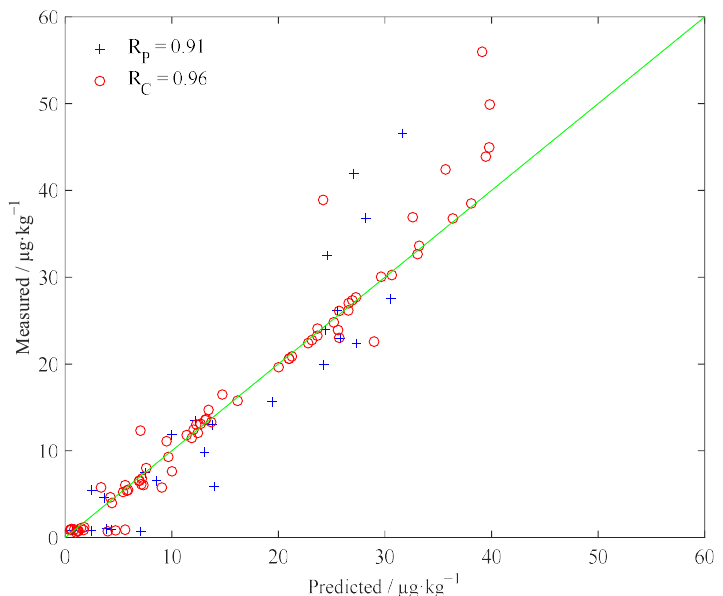
Figure 4. Scatter plot between the predicted value of the AFB 1 in peanuts by the optimal SSA-SVR model and the reference measured value.